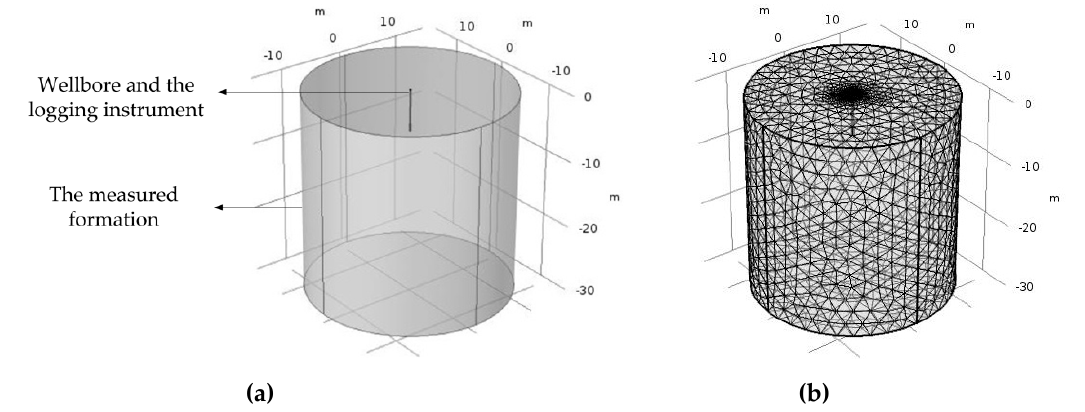
Figure 10. Simulation setup of the logging instrument: ( a ) setup; ( b ) meshing diagram.